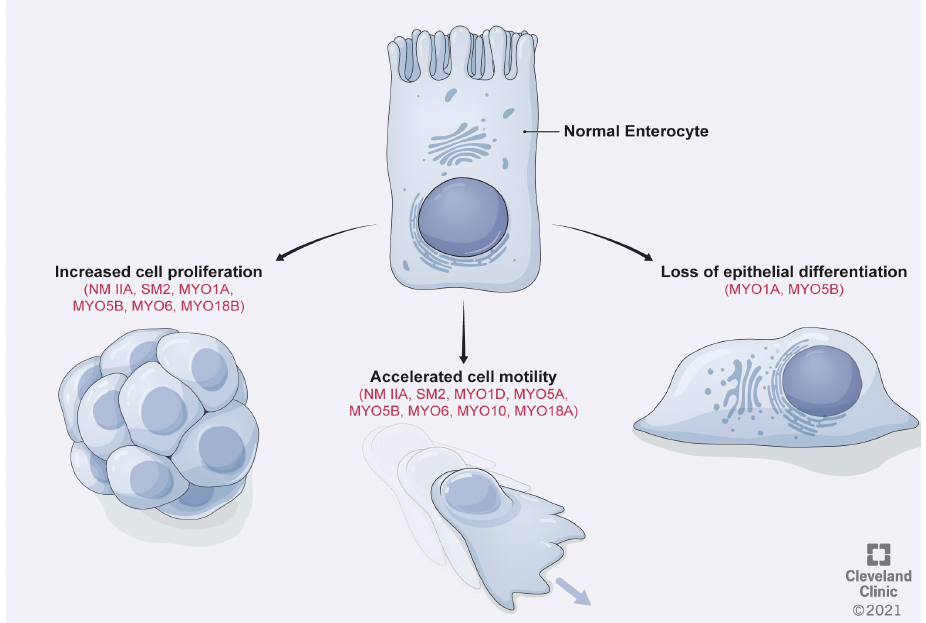
Figure 2. Functional effects of abnormal myosin activities in colon cancer cells. This figure depicts the known or proposed functional effects of altered expression or activity of different myosins in colon cancer cells that include increased cell proliferation, accelerated motility and loss of epithelial differentiation. See the text for abbreviations of different members of the myosin superfamily. Figure 2 by Brandon Stelter, BFA. Reprinted with the permission of the Cleveland Clinic Center for Medical Art & Photography © 2021. All Rights Reserved.